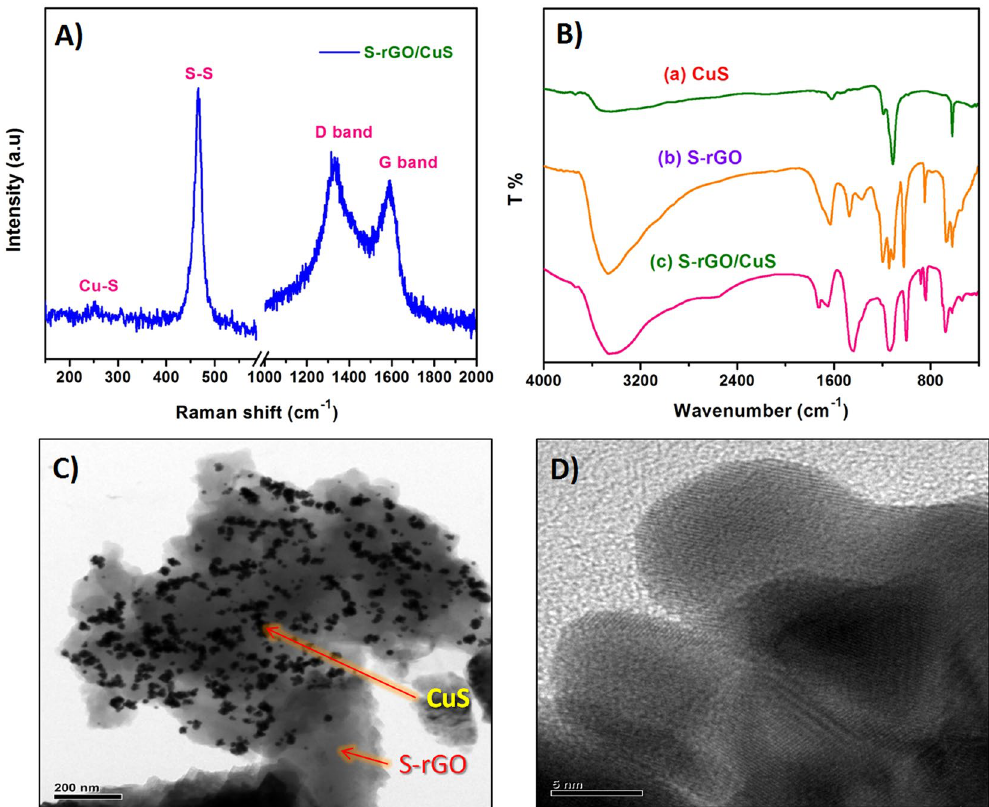
Figure 4. Raman spectrum ( A ) of S-rGO/CuS, FT-IR spectrum ( B ) of CuS (a), S-rGO (b), S-rGO/CuS (c), TEM images of low ( C ) and high magnification of ( D )